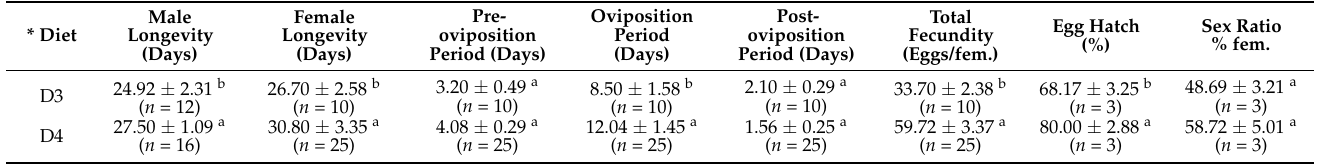
Table 2. Mean ± SE of the adult longevity and reproductive output of S. gilvifrons fed diets containing A. franciscana cysts.